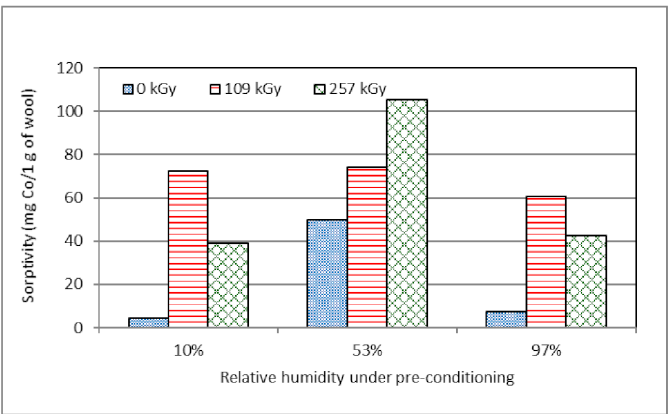
Figure 9. Variation of wool sorptivity 160 days after electron irradiation depending on RH under pre-exposition conditioning.